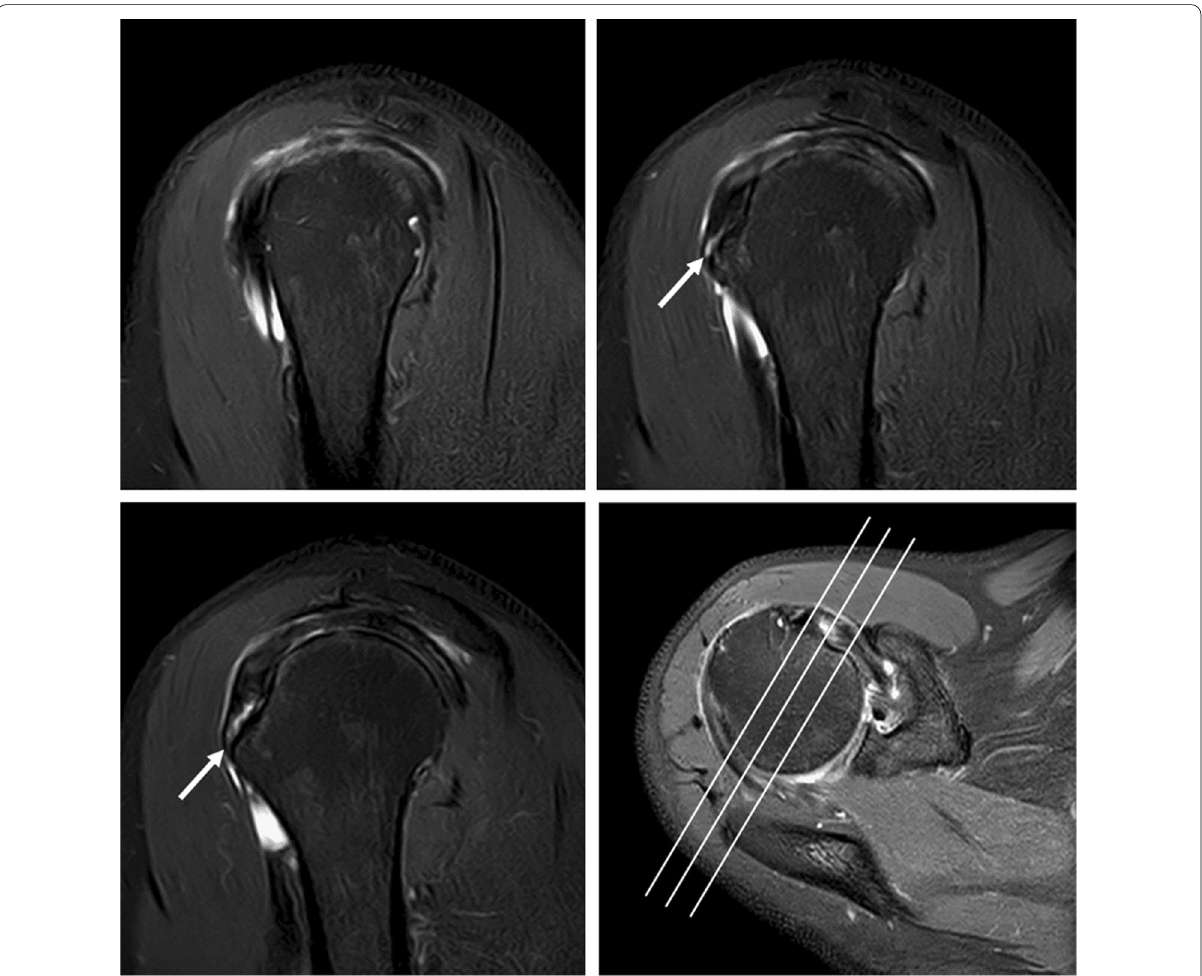
Fig. 1 Type-A of fissure sign. There is a transverse fluid-filled gap in the interface between cortex and tendon of SSC footprint at the first three slices on oblique sagittal IM-WI/fs MRI which counted from the most lateral cortex of lesser tuberosity to the medial SSC footprint area referring to the axial MR image, and must be found at least two continuous slices (white